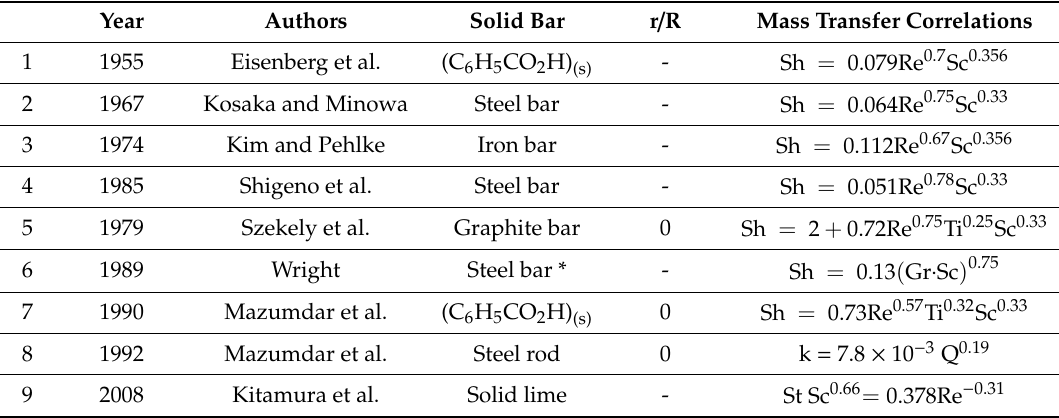
Table 1. Mass transfer correlations for solid–liquid and gas–solid–liquid